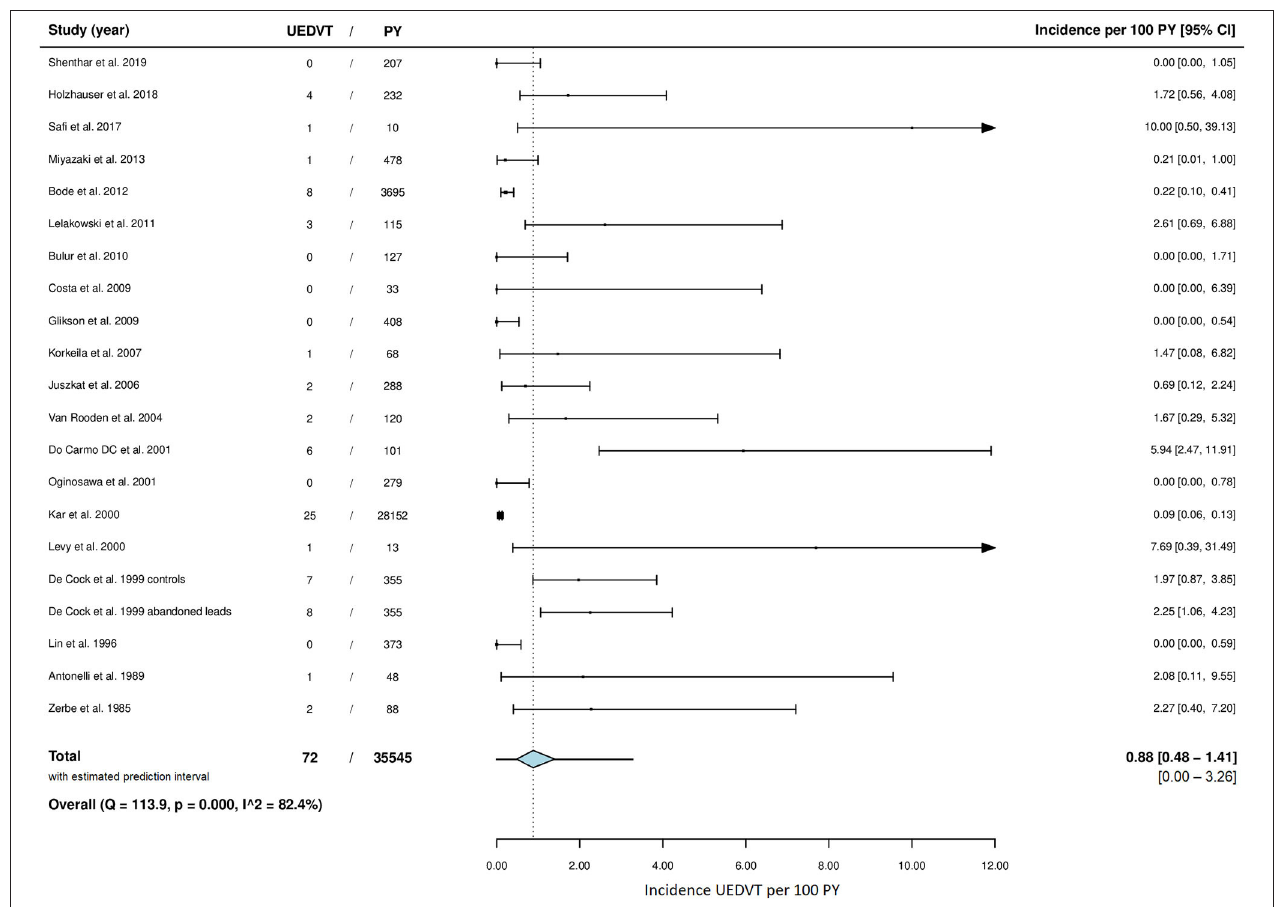
FIGURE 2 | Meta-analysis of incidence rate of UEDVT. CI, confidence interval; PY, patient years; UEDVT, upper extremity deep vein thrombosis.